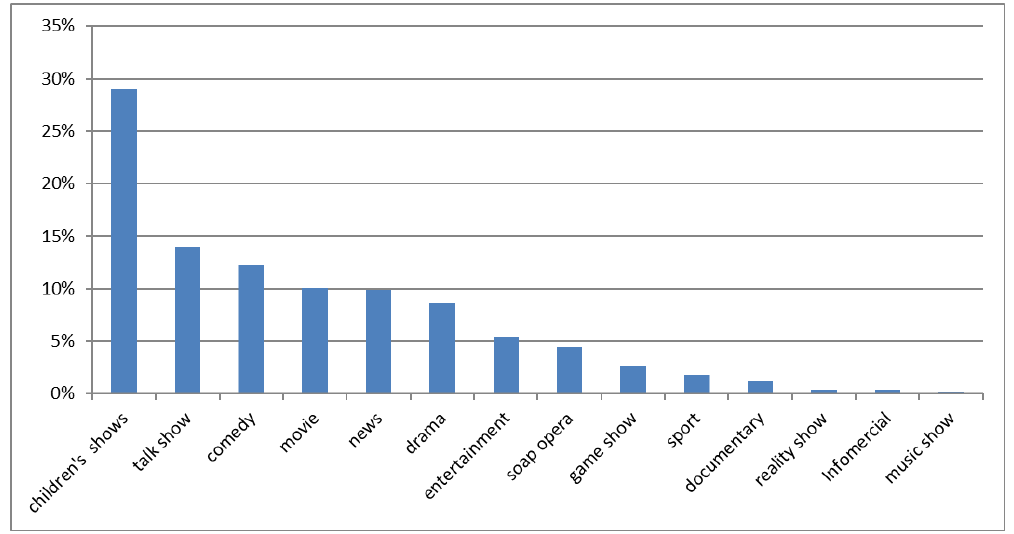
Figure 1. Distribution of food and beverage commercials among the types of programs. * Statistically significant ( p =